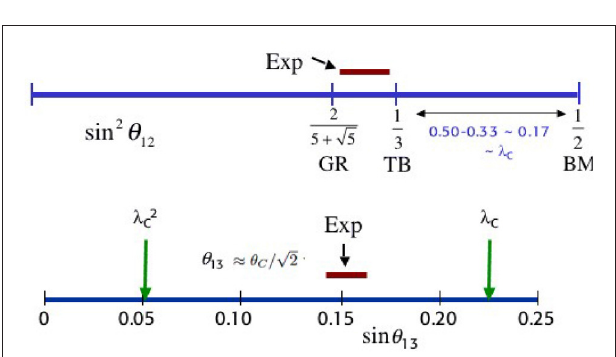
FIGURE 7 | Comparison of the experimental value of the leptonic mixing angles against their exact predictions by TBM, GR and BM mixings. Figure from Altarelli et al. [